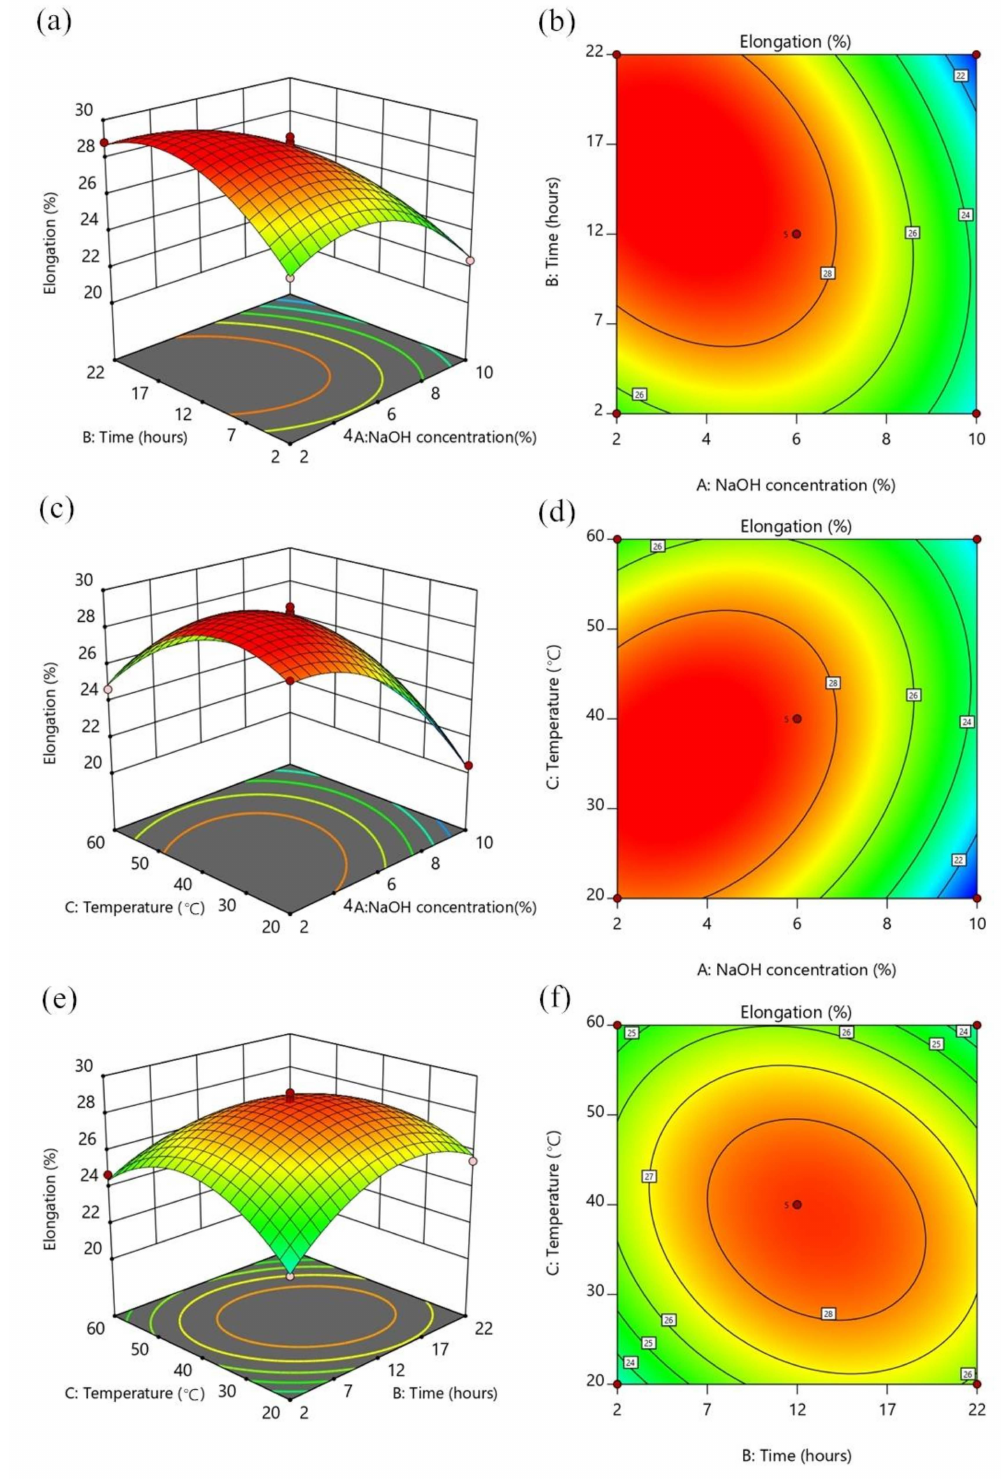
Figure 6. Effect of NaOH concentration and time on elongation of coir fiber at a temperature of 40 ◦ C: ( a ) three-dimensional surface plot; ( b ) contour plot. Effect of NaOH concentration and temperature on elongation of coir fiber at a time of 12 h: ( c ) three-dimensional surface plot; ( d ) contour plot. Effect of time and temperature on elongation of coir fiber at a NaOH concentration of 6%: ( e ) three-dimensional surface plot; ( f ) contour